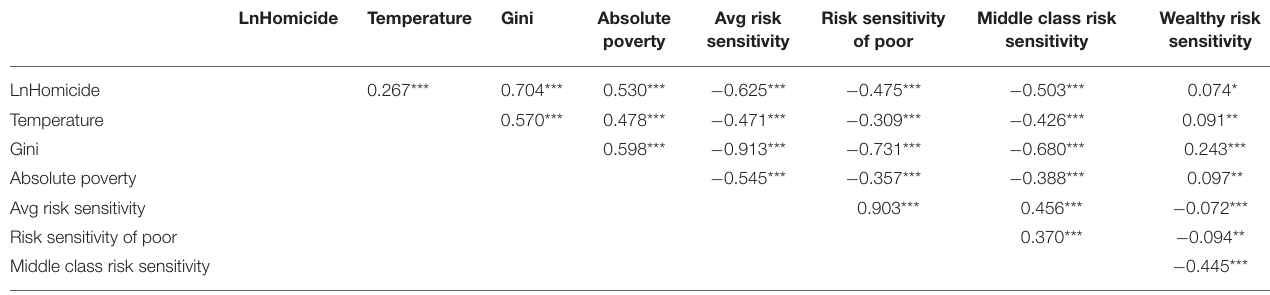
TABLE 1 | Correlations between key variables.